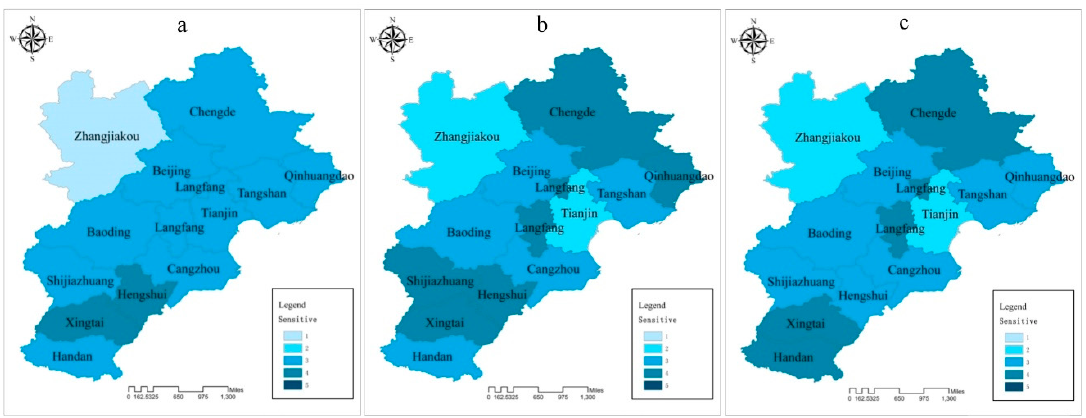
Figure 4. Individual assessment indices of sensitivity ( a ): 2013; ( b ): 2014; ( c ): 2015.